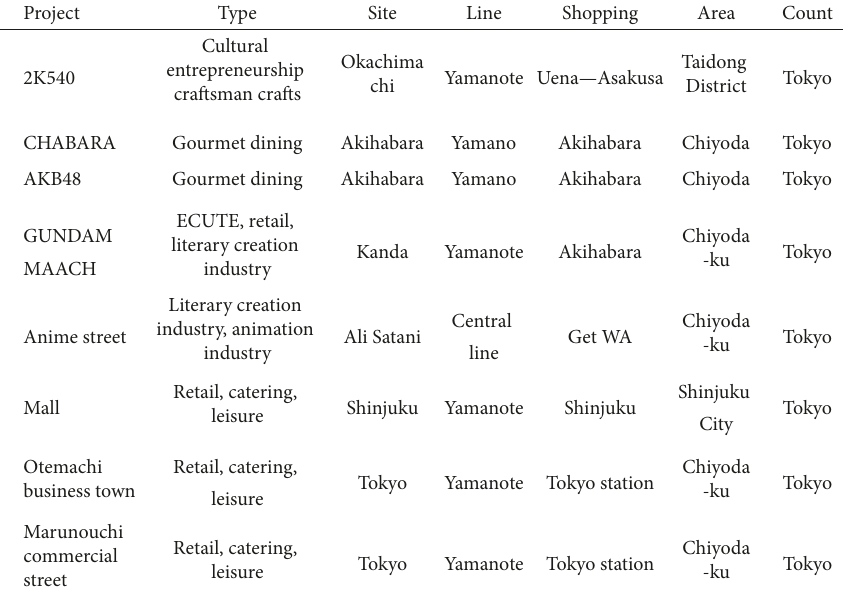
Figure 2: List of JRUD Tokyo space under overpasses development projects.